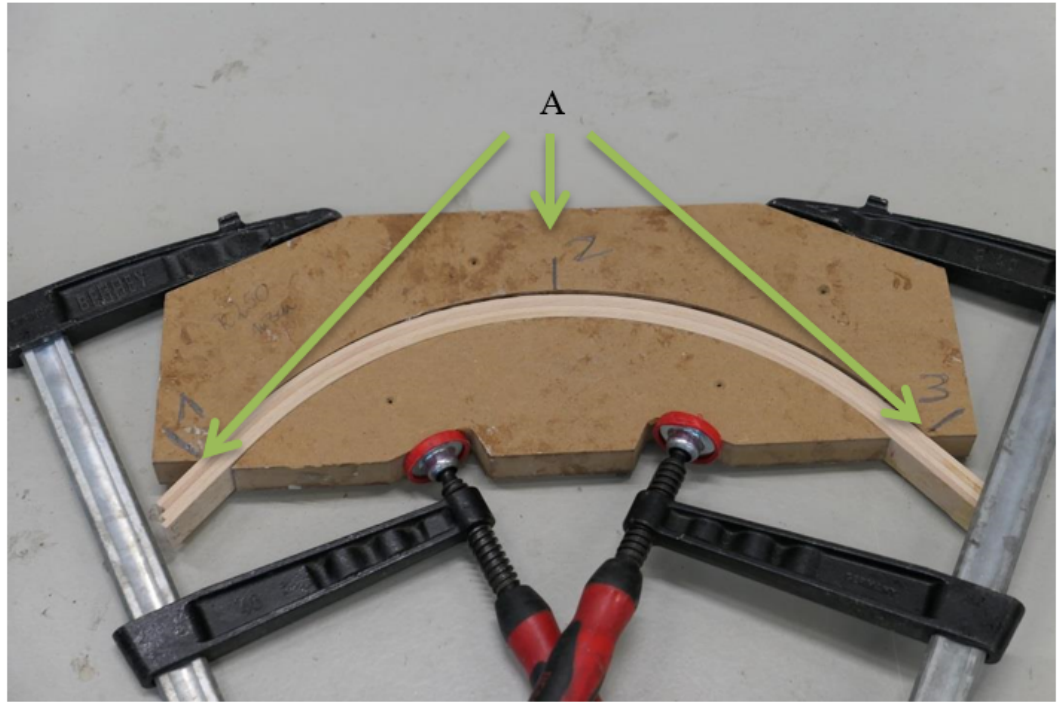
Figure 2. MDF die design and clamp setup. The measurement points (A) to determine the radius are marked with arrows.